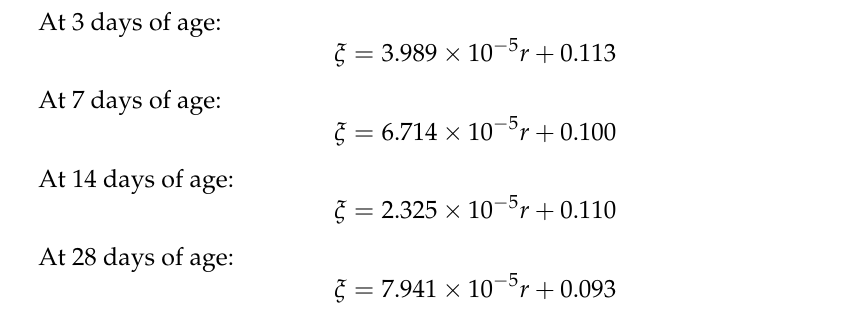
Figure 12. Compression–shear coefficient fitting of